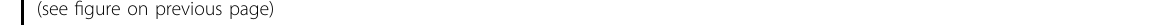
Fig. 4 Insulin regulates dynamics of IRS1 condensates in cells. a Dynamics of IRS1-GFP condensates in U2OS cells upon insulin stimulation. Cells transfected with IRS1-GFP were stimulated with insulin (100 nM) for indicated time. Insets show the formation of IRS1-GFP condensates. Scale bar, 10 μ m. b , c Formation of endogenous IRS1 condensates in L6 muscle cells upon insulin stimulation. b Representative images. c Fitted curves of cell distribution in terms of IRS1 condensate (puncta) number per cell. The values were fi tted into curves using polynomials. n = 81 – 96. Scale bar, 5 μ m. d , e Formation of endogenous IRS1 condensates in U2OS cells upon insulin stimulation. d Fitted curves of cell distribution in terms of IRS1 condensate (puncta) number per cell. The values were fi tted into curves using polynomials. n = 102 – 119. e Representative images. Scale bar, 10 μ m. f , g Effects of palmitate (PA) treatment on insulin-induced formation of IRS1 condensates in L6 muscle cells. Cells were treated with or without palmitate (400 μ M) for 24 h before stimulated with or without insulin (100 nM). f Representative images. Scale bar, 10 μ m. g Quanti fi cation of IRS1 puncta per cell. n = 50. The data are given as the means ± SEM. Statistical analyses were carried out via two-way ANOVA. * p < 0.05, and *** p < 0.001. h – j Effects of the PKC inhibitor Gö6983 on PKB phosphorylation and IRS1 puncta formation in L6 muscle cells. Cells were treated with or without palmitate for 24 h before stimulated with or without insulin in the presence or absence of Gö6983 (1 μ M). h Representative images of IRS1 puncta. Scale bar, 10 μ m. i Quanti fi cation of IRS1 puncta per cell. n = 55-62. j Immunoblotting analysis of PKB phosphorylation. The data are given as the means ± SEM. Statistical analyses were carried out via two-way ANOVA. *** p < 0.001. n.s., not signi fi